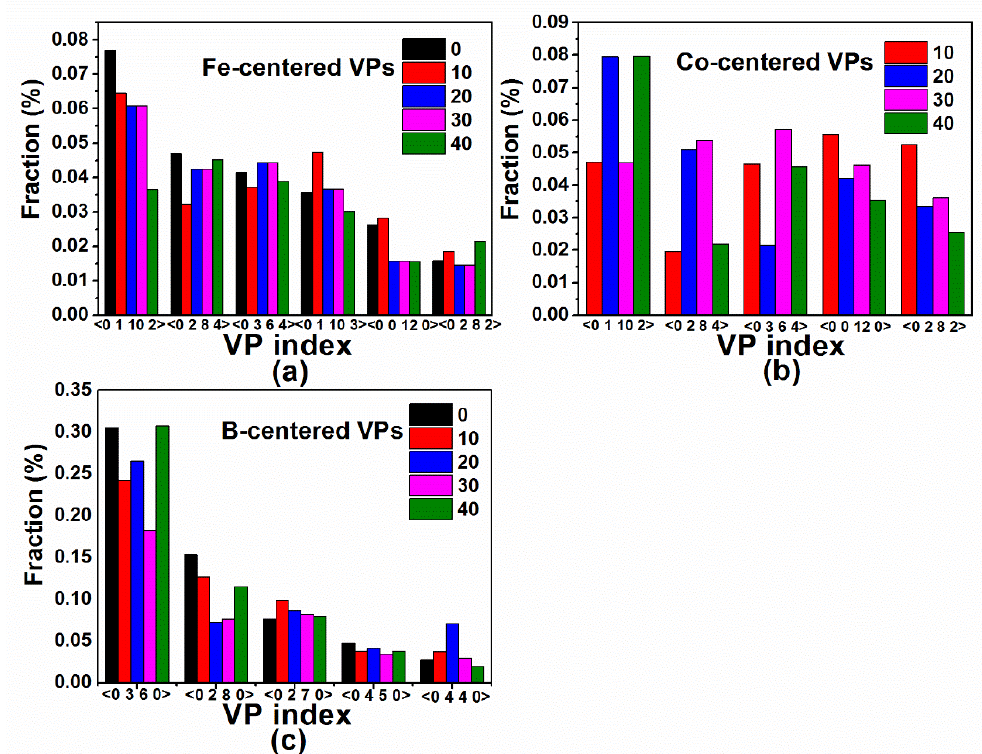
Figure 3. Numbers of Voronoi polyhedral (VPs) with central ( a ) Fe, ( b ) Co, and ( c ) B atoms in Fe 80 − x Co x B 20 (x = 0, 10, 20, 30, and 40 at.%) amorphous alloys at 300 K. VP index is expressed as < n n n > , where n (cid:3036) denotes the number of the i-edged faces of Voronoi polyhedron.